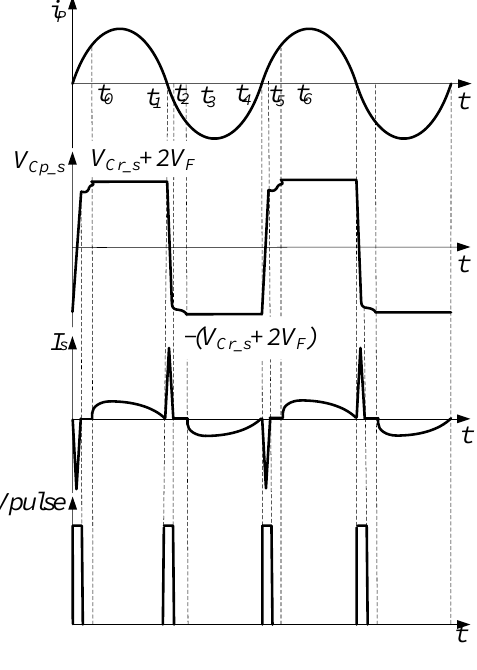
Figure 5. Waveforms in P-SSHI.